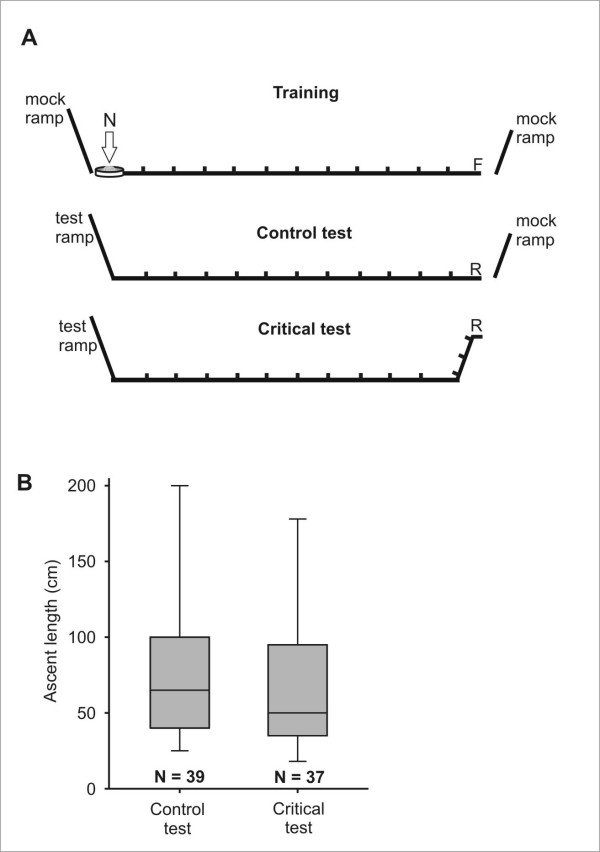
Experiment 3: Induction of a negative vertical vector component. (A) Schematic lateral view of the channels used in training, control, and critical test. Small marks indicate the presence of landmarks within the channel (refer to text). Mock ramps in the training and control situation served to provide similar visual environments in all three situations. (B) Distribution of lengths of the first ascent in the control and critical test. The results from both test situations did not differ from each other (p > 0.1, Mann-Whitney U-test).